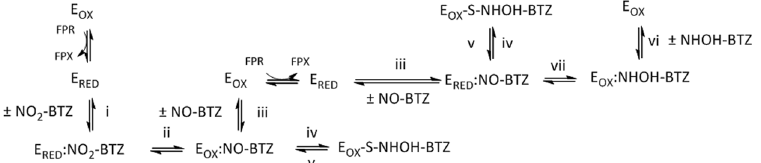
Figure 1. Mechanism of inhibition of DprE1 by BTZs. (i) noncovalent recognition of nitro(NO 2 )-BTZs by DprE1; (ii) reduction of nitro-BTZs to nitroso(NO)-BTZs by DprE1; (iii) release of nitroso-BTZs; (iv) covalent binding of nitroso-BTZs to Cys387; (v) cleavage of the bond between BTZs and DprE1; (vi) noncovalent recognition of hydroxylamino(NHOH)-BTZs by DprE1; (vii) oxidation of the hydroxylamino-BTZs to nitroso- BTZs by